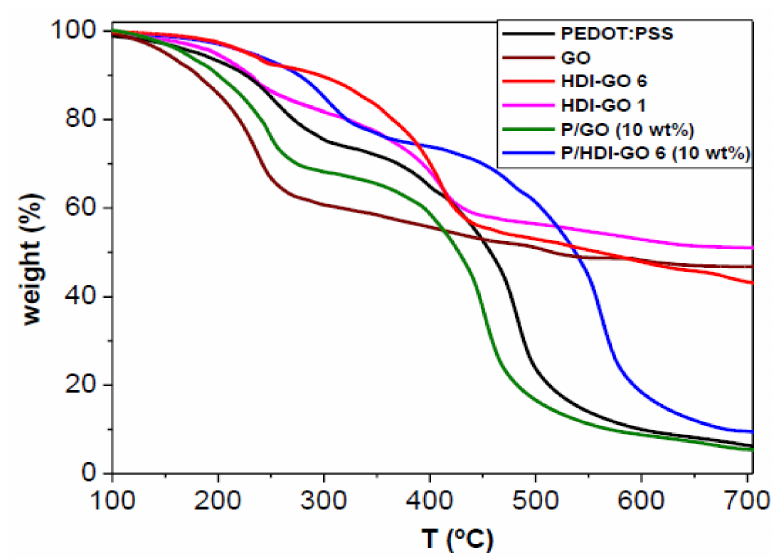
Figure 4. TGA curves under inert atmosphere of neat PEDOT:PSS, raw GO, HDI-GO 1, HDI-GO 6, and the nanocomposites with 10 wt % nanofiller